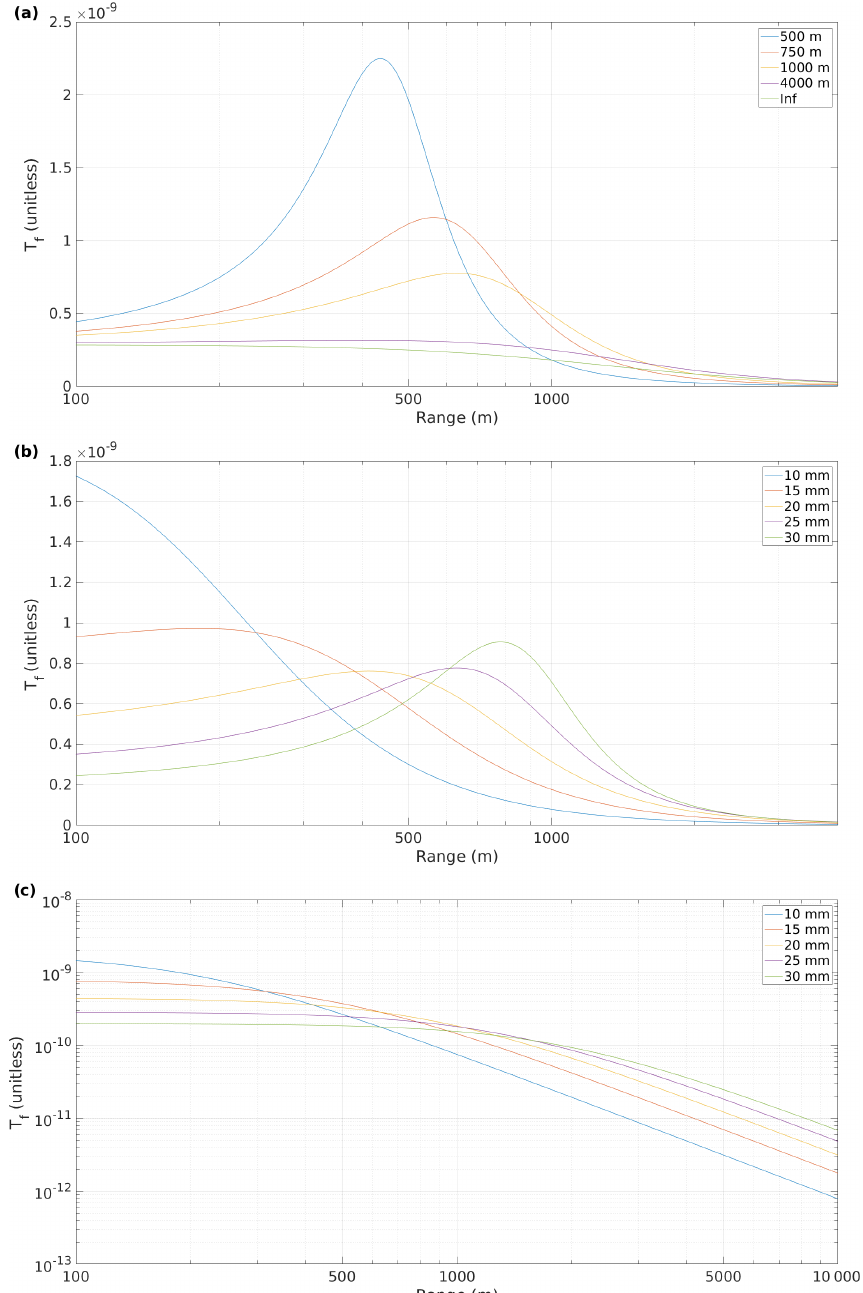
Figure 1. Telescope focus functions for (a) varying f with D = 70mm, (b) varying D with f = 1000m, and (c) varying D with f being